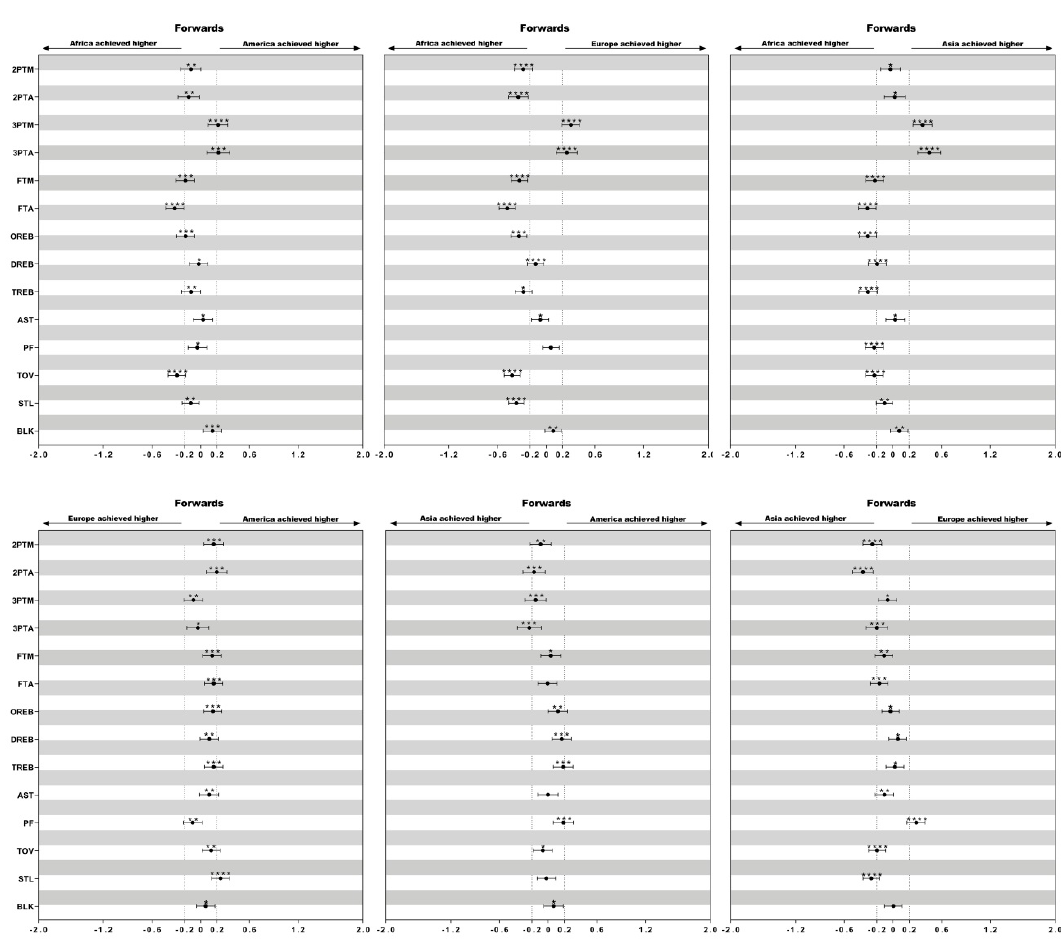
Figure 2. Standardized di ff erences of technical performances in forwards among di ff erent continental championships. Bars present 90% confidence intervals. Asterisks indicate the likelihood for the magnitude of the true di ff erence as follows: * possible; ** likely; *** very likely; **** most likely. Asterisks located in the area between − 0.2 and 0.2 denote for trivial di ff erences.